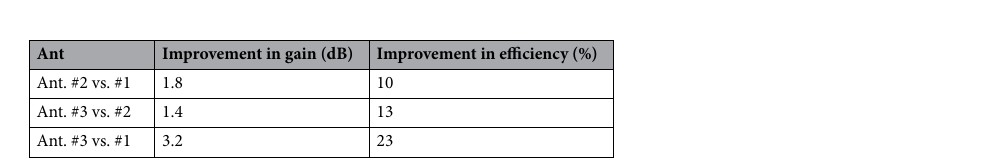
Table 4. Gain & radiation efficiency comparison of the three